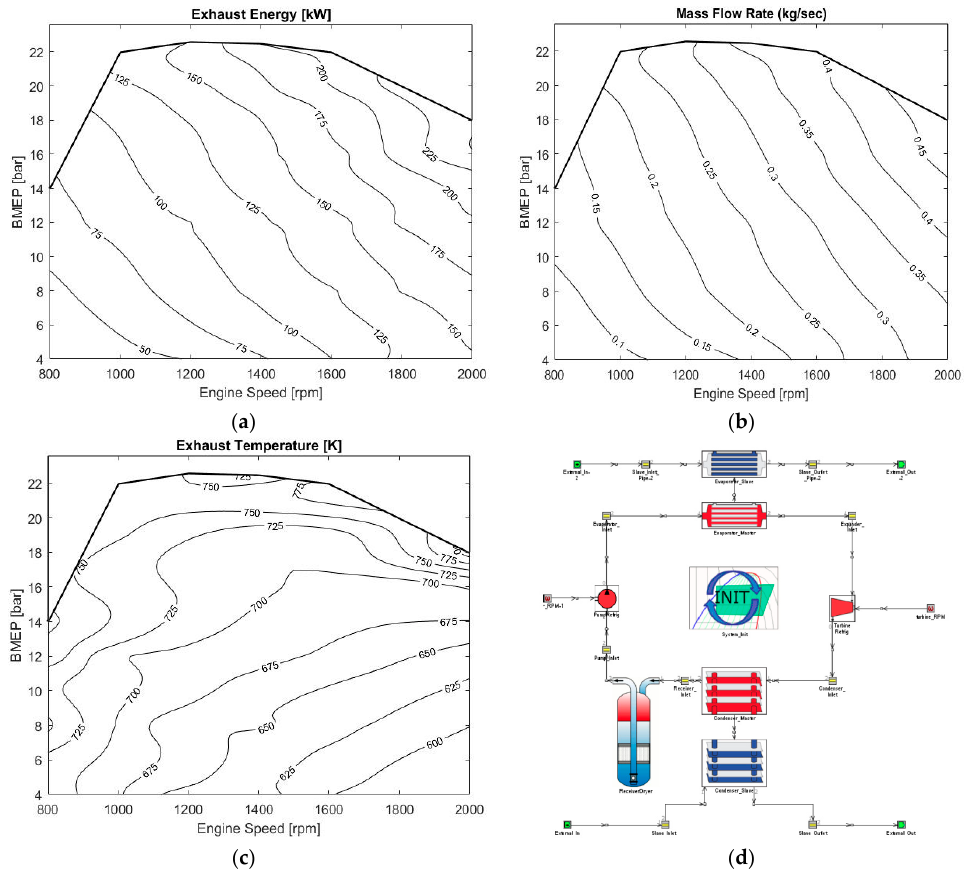
Figure 2. Modeled engine exhaust maps: ( a ) Exhaust available energy of engine based on BMEP map; ( b ) Exhaust mass flow rate of engine based on BMEP map; ( c ) Exhaust temperature of engine based on BMEP map; ( d ) Schematic view of ORC system modeled in GT-Power code.